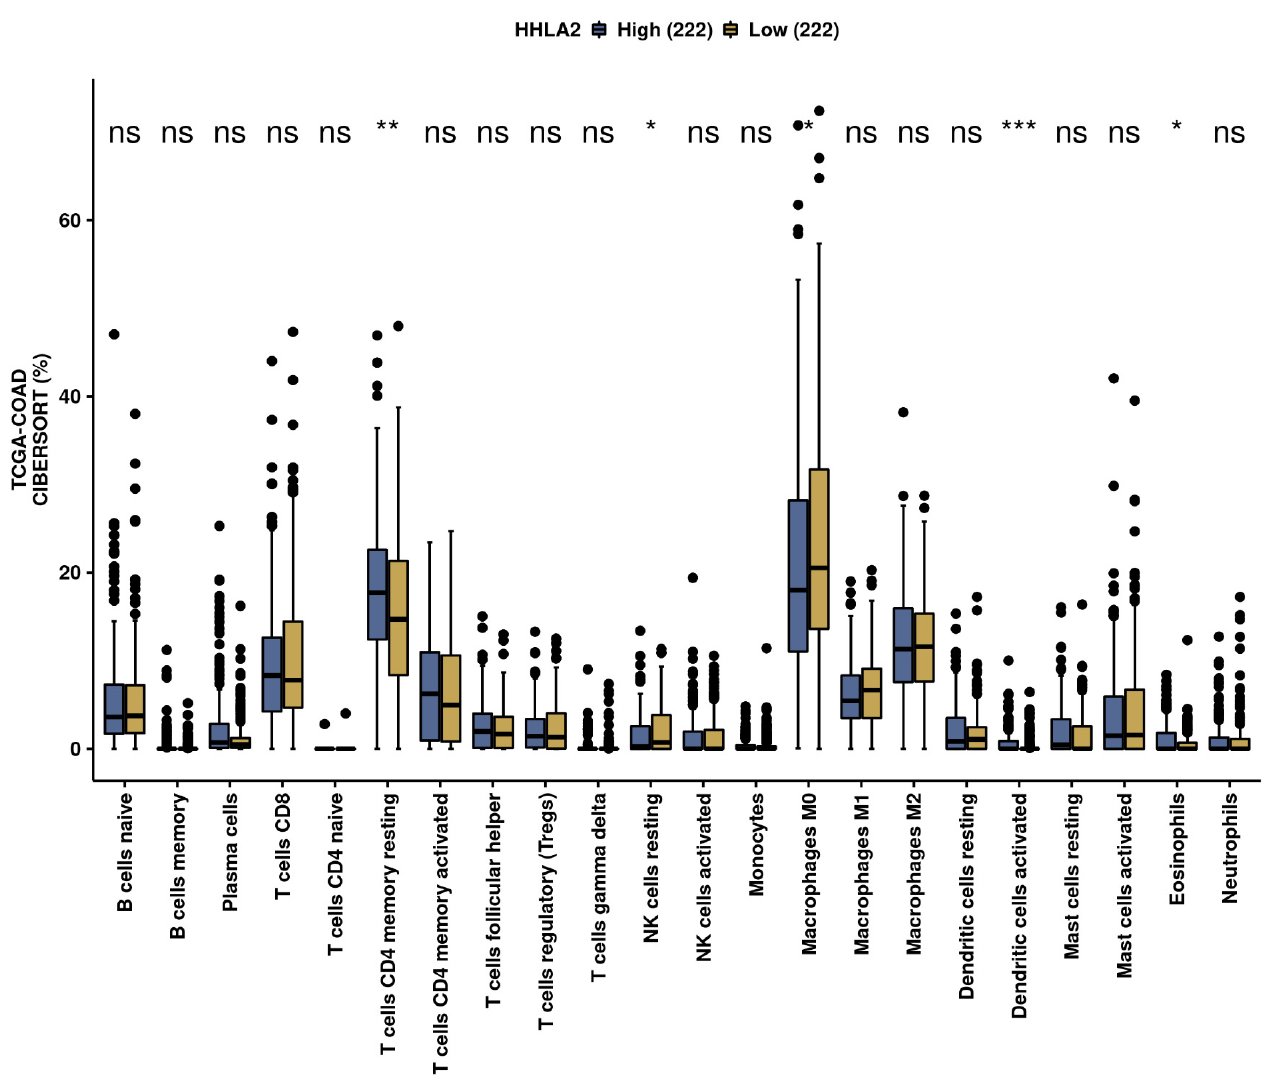
Figure 11. The immunological landscape of CRC related to HHLA2 expression, with analyses based on THE CANCER GENOME ATLAS-COLON ADENOCARCINOMA (TCGA-COAD) dataset. Immune cell infiltration scores calculated by CIBERSORT method by the web-based tool Camoip in high- and low- HHLA2 -expression groups; * p < 0.05, ** p < 0.01, and *** p < 0.001; ns = not significant.